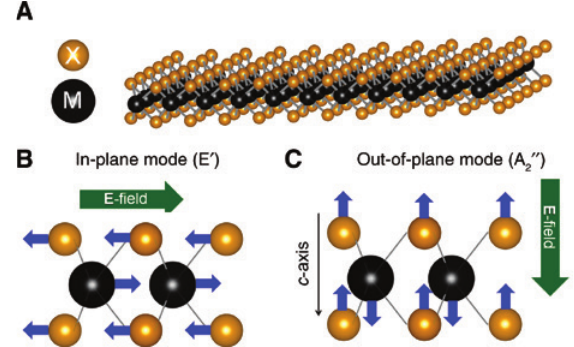
Figure 10: Structure and IR active phonons of TMDs. (A) A monolayer TMD in hexagonal (trigonal prismatic)